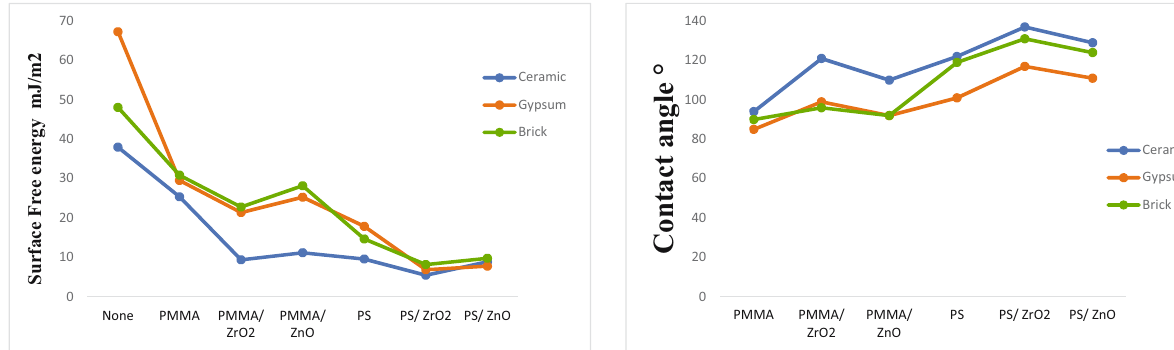
Figure 4: Surface free energy results for di ff erent coated surfaces. Figure 5: CA results for di ff erent coated surfaces after exposure to weathering e ff ects.